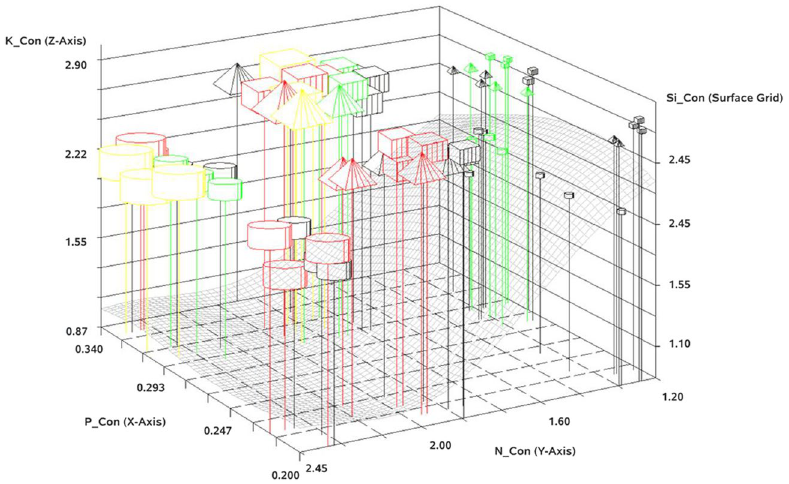
Figure 8. Relationship among measured rice plant attributes and brown planthopper (BPH) fitness traits for net reproductive rate ( R 0